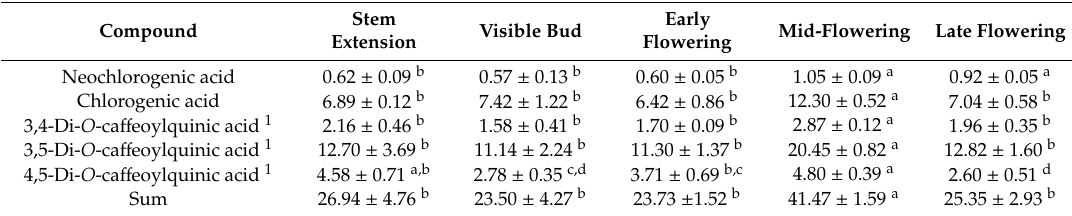
Table 3. Individual phenolic compound contents in the sunflower extracts (mg / g extract) obtained from plants at various growth stages.